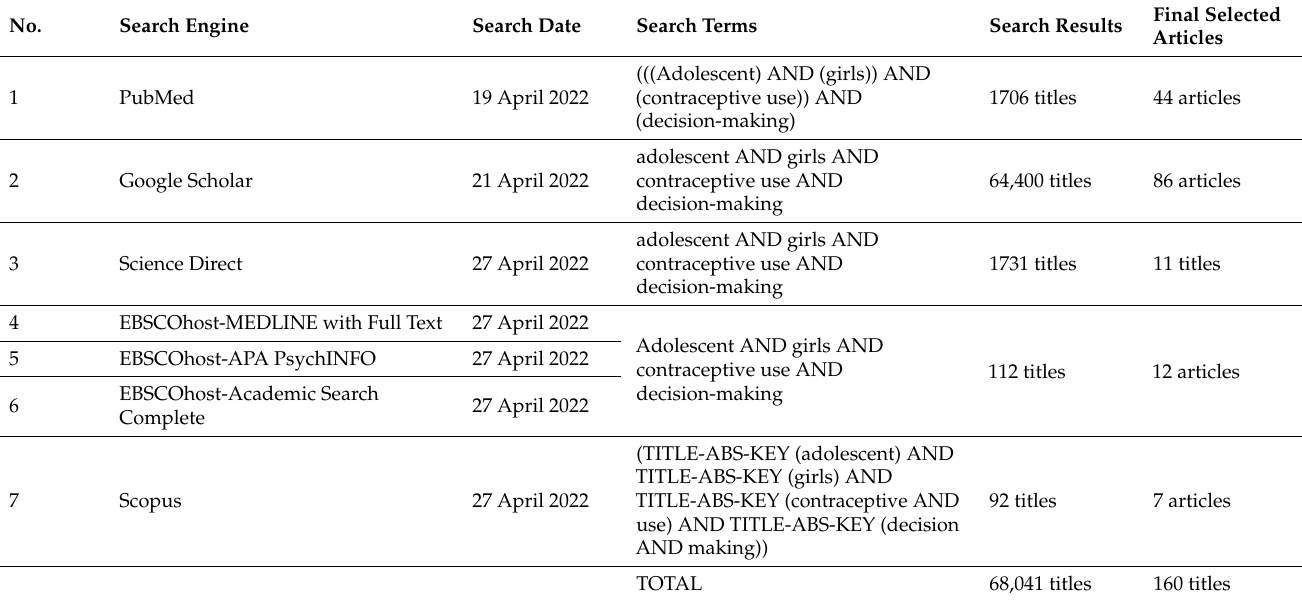
Table 3. Title screening search